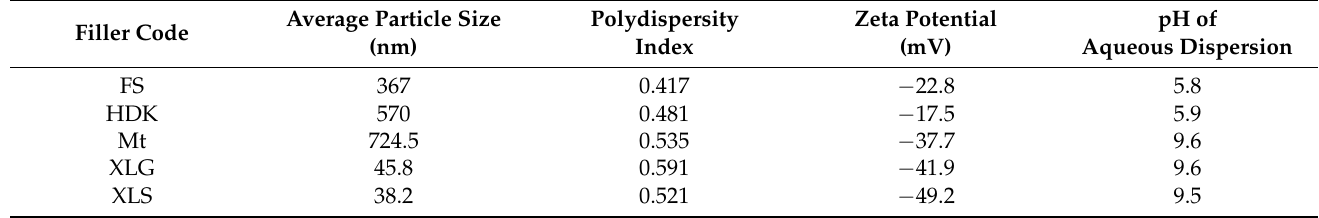
Table 1. Characteristics of the investigated fillers and their aqueous dispersions 1